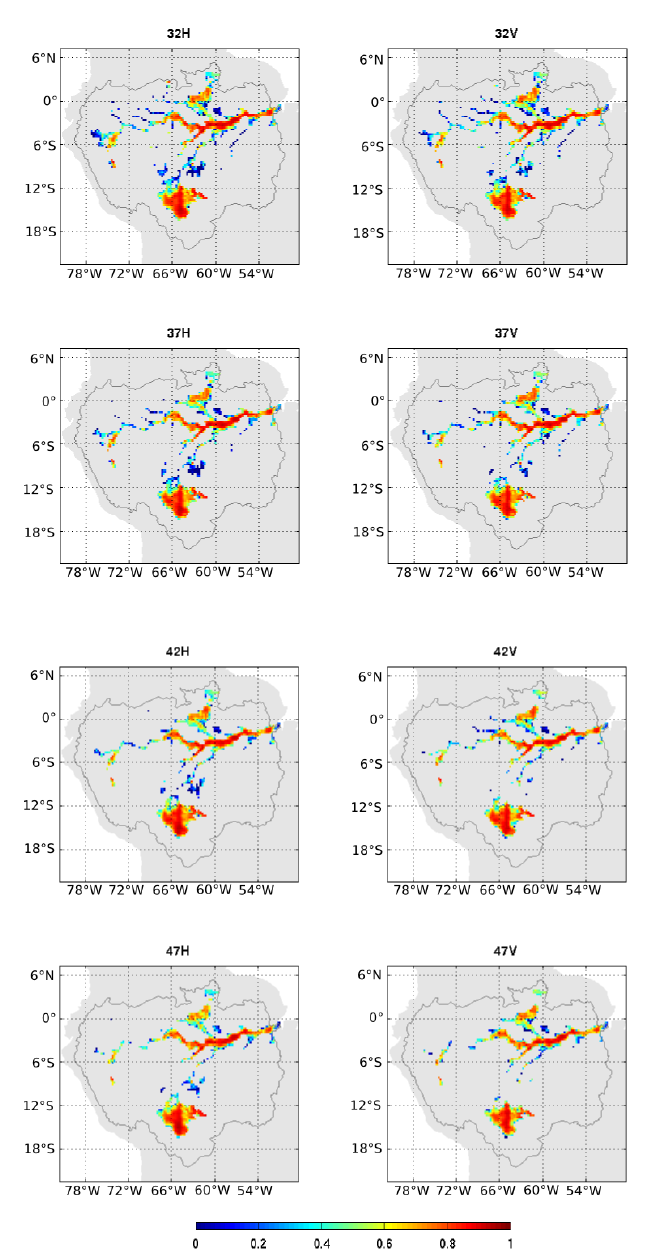
Figure 12. Temporal correlation values between the SWAMPS and SWAF products from January 2010–March 2013 for each SMOS